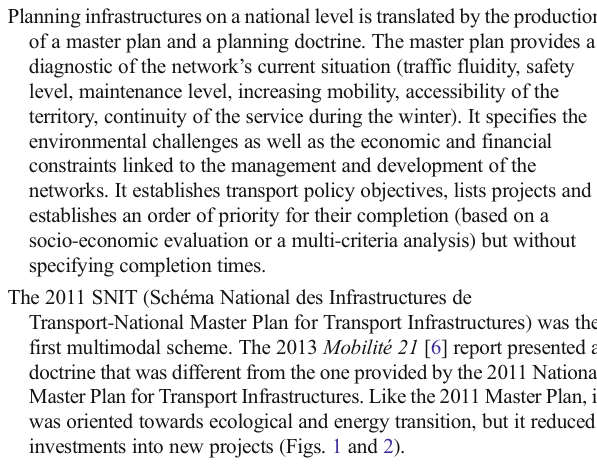
Short description of national planning of transport infrastructures